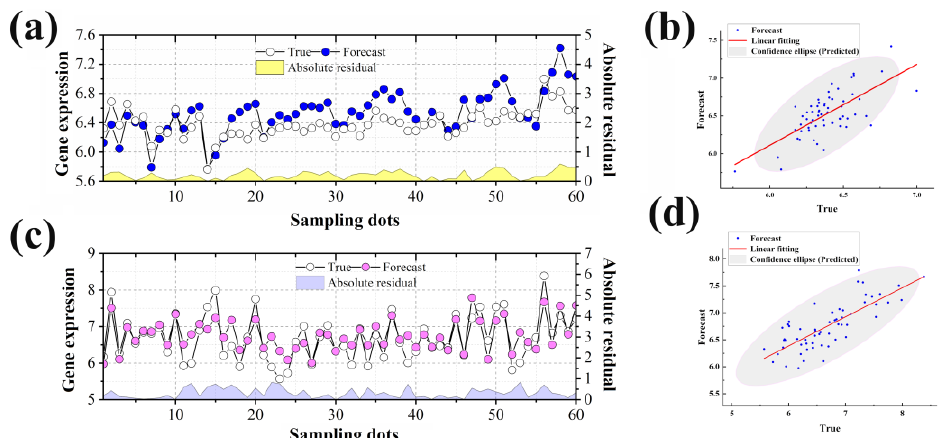
Figure 6. Overall prediction results. ( a , b ): RMSE value of 0.2558, MAE value of 0.2105, and R 2 of 0.4771 at 0 h. The overall prediction error is low and there is a high agreement between the prediction results and the true values. ( c , d ): RMSE value of 0.4002, MAE value of 0.3169, and R 2 of 0.6145 for the reverse time prediction of 6 h. It also shows low error and excellent agreement between the prediction results and the true values.